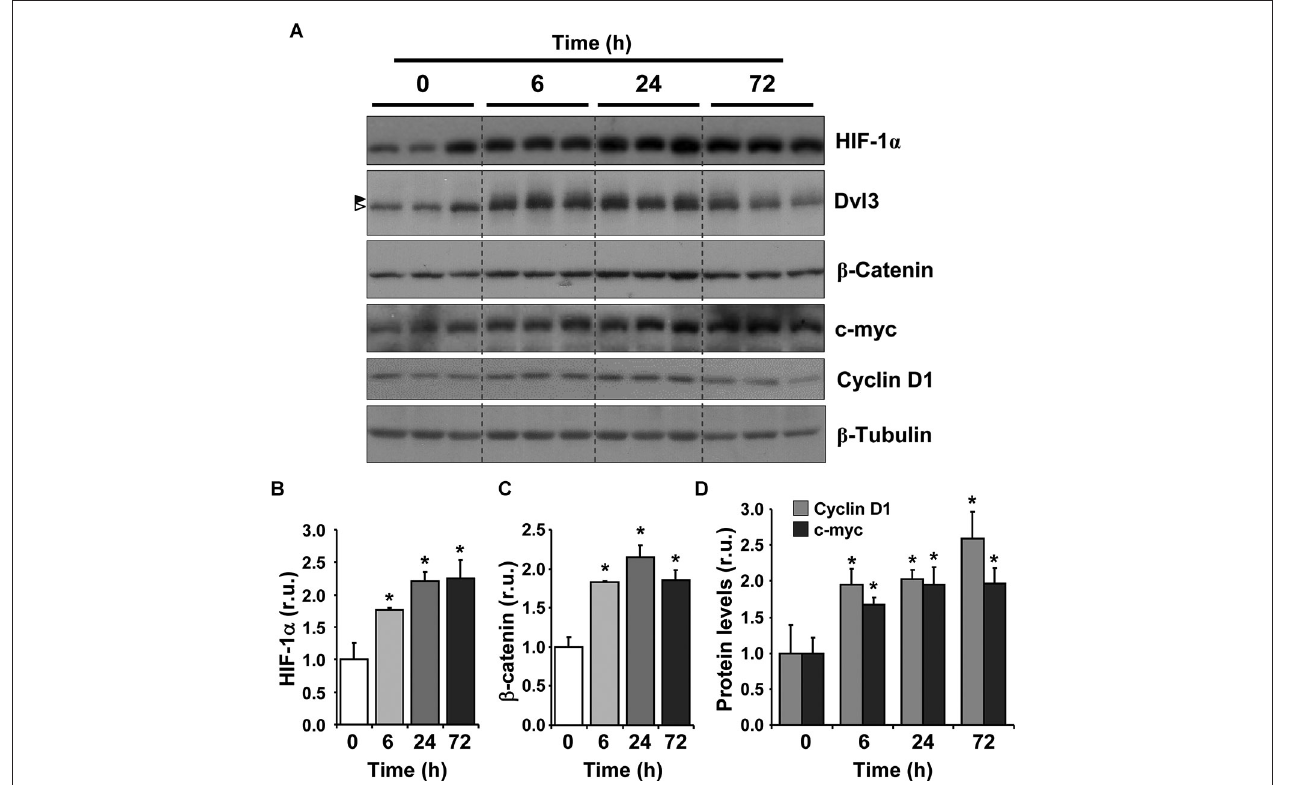
Dvl3 immunoblot, arrowheads on the left indicate dephosphorylated (white) and phosphorylated and shifted (black) Dvl3. (B–D) Densitometric analysis expressed in relative units (r.u.) of HIF-1 α (B) , β -catenin (C) , cyclin D1 and c-myc (D) levels normalized to β -tubulin levels and compared to control mice that were not exposed to hypoxia. Bars represent mean ± S.E ( n = 3 mice). * p <